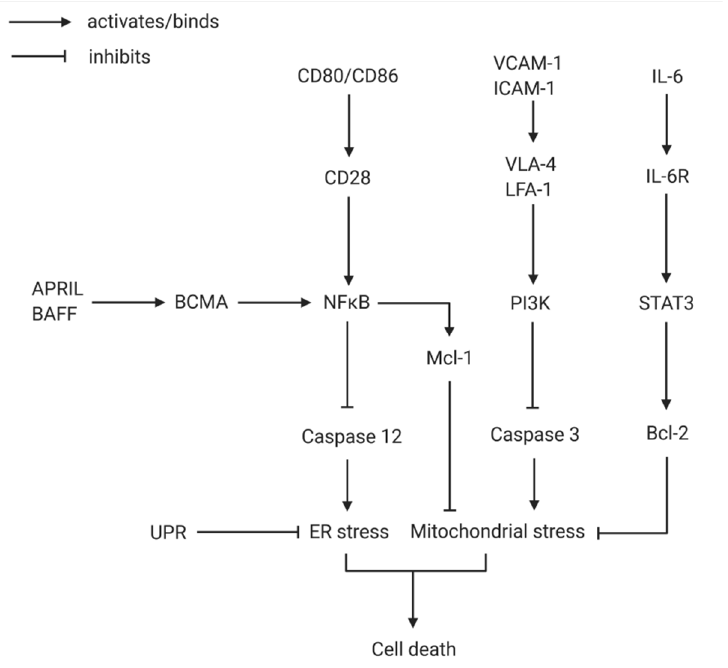
Figure 1. The network of molecular interactions preventing plasma cell death. Due to the plasma cells’ purpose as antibody mass-producers, ER and mitochondrial stress emerge easily. The activation of NF- κ B via CD80/86 binding to CD28 and APRIL/BAFF stimulating BCMA leads to the inhibition of caspase 12, an important factor in ER stress induced cell death. UPR is the main mechanism working against ER stress. By inducing the expression of Mcl-1, NF- κ B additionally stifles mitochondrial stress. Mitochondrial stress is further suppressed by inhibition of caspase 3 via stromal-cell-contact-induced PI3K. Furthermore, Bcl-2 is known as a crucial antagonist of mitochondrial stress-inducing proteins and is located at the end of the IL-6 signaling cascade. ER, endoplas- mic reticulum; UPR, unfolded protein response (Created with BioRender.com).